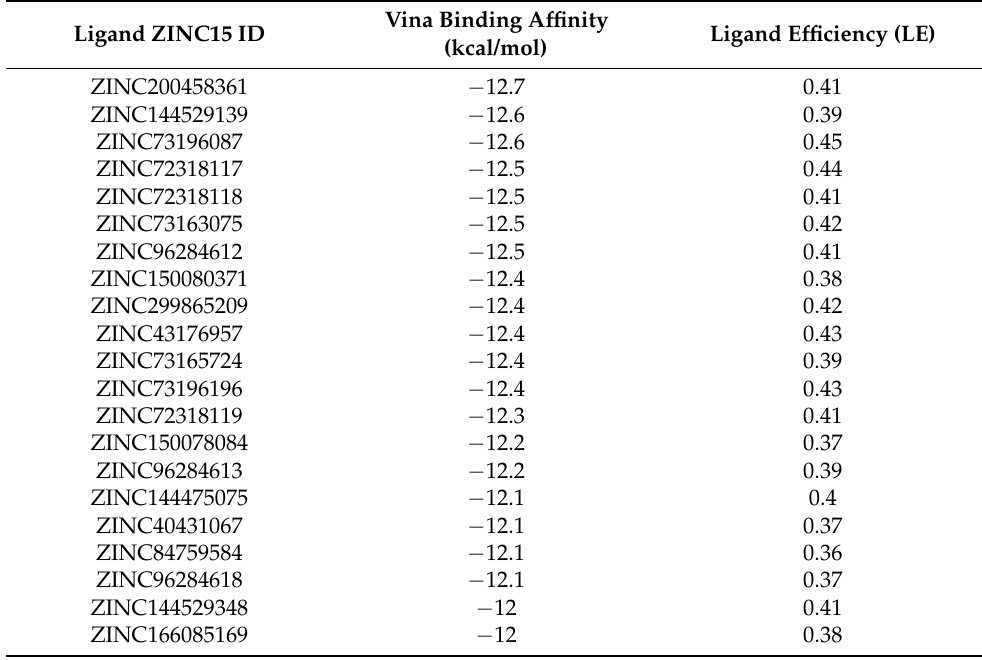
Table 2. The ZINC molecules presented the best binding affinities to